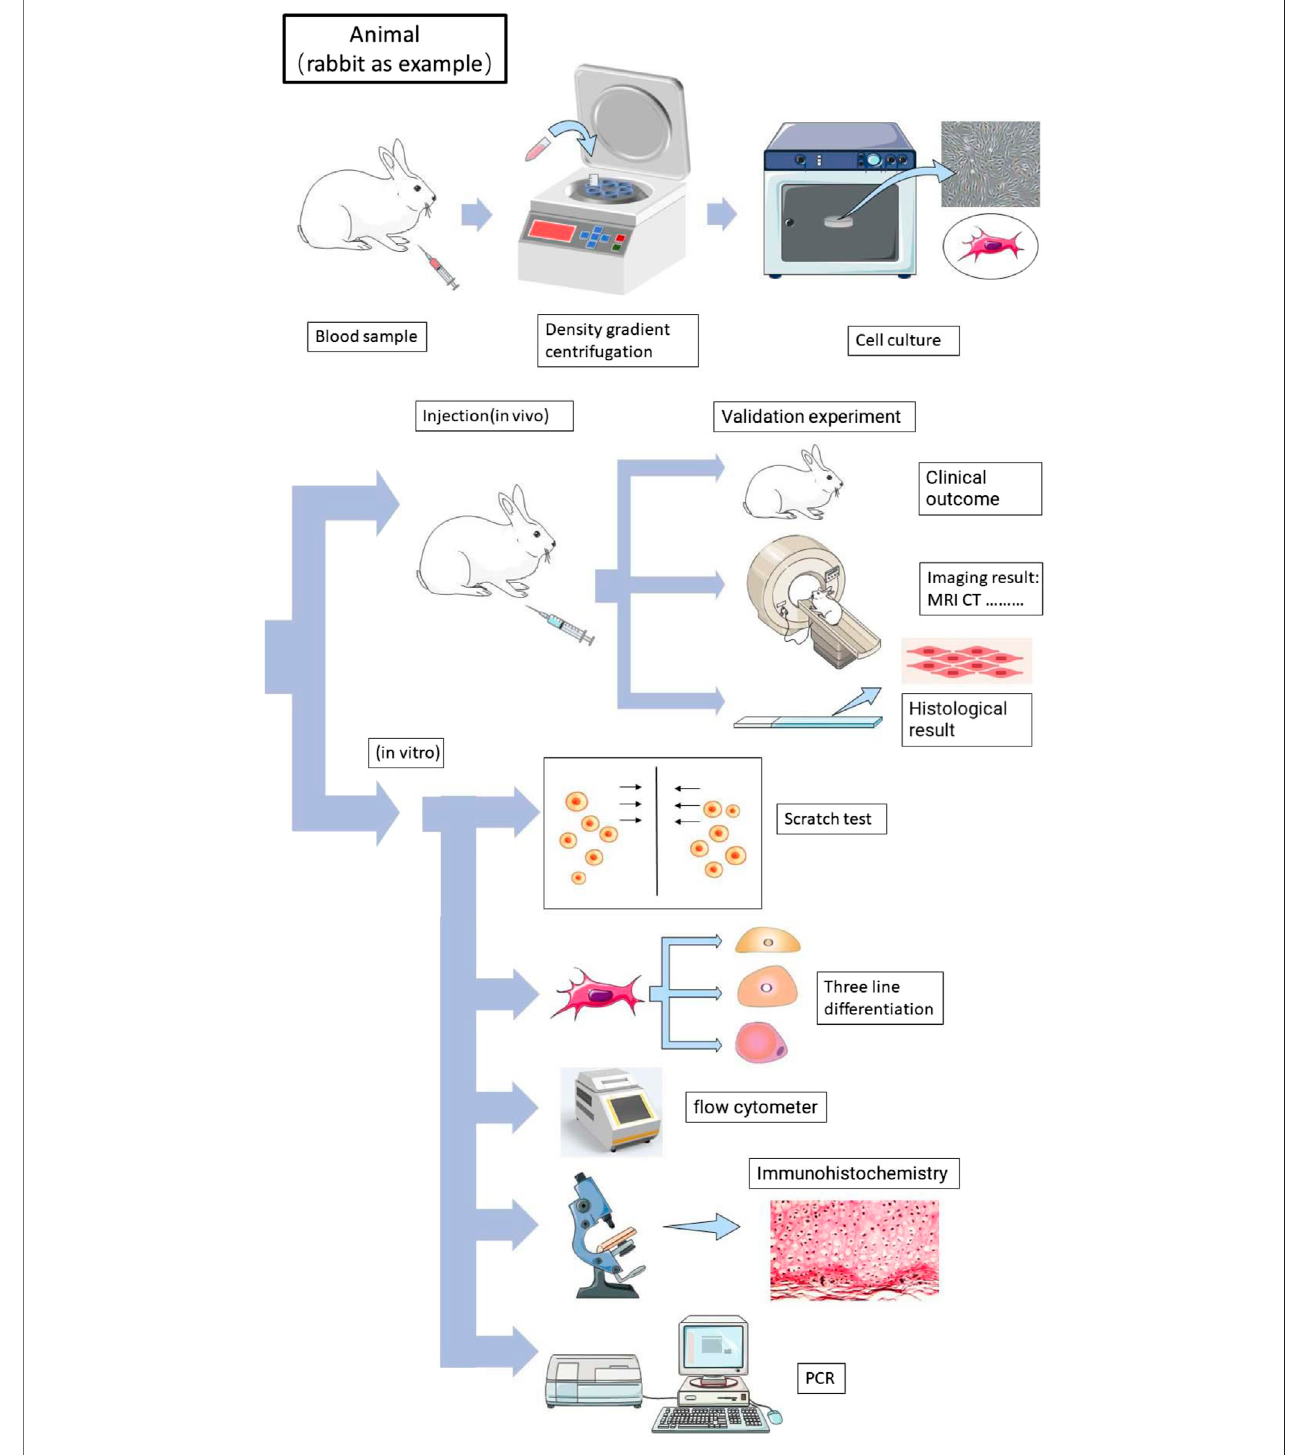
FIGURE 3 | The general process of animal and in vitro peripheral blood-derived stem cell experiments (rabbit as an example).